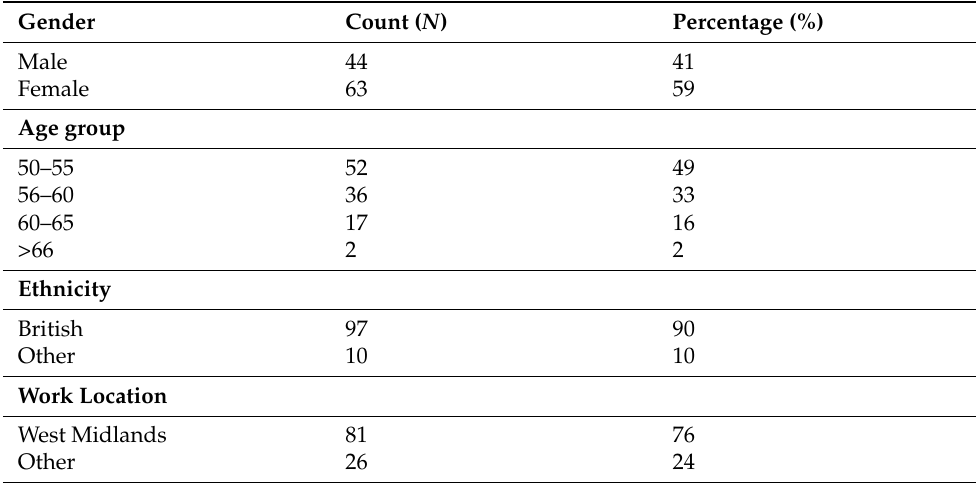
Table 5. Survey phase respondent socio-demographic characteristics ( N =